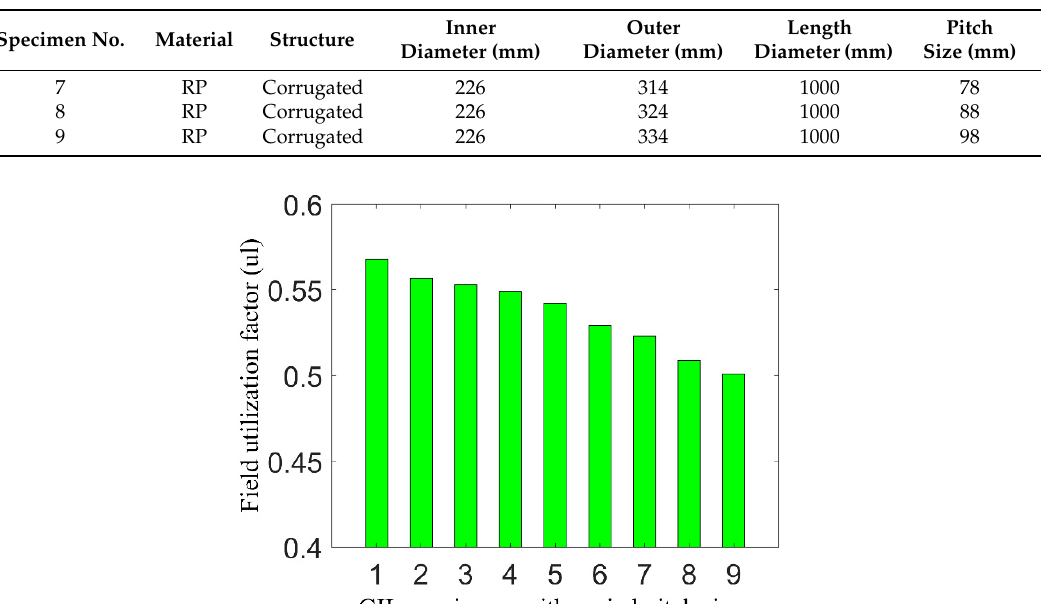
Table 4. Detailed specification of open cell foam samples used in the experimentation.